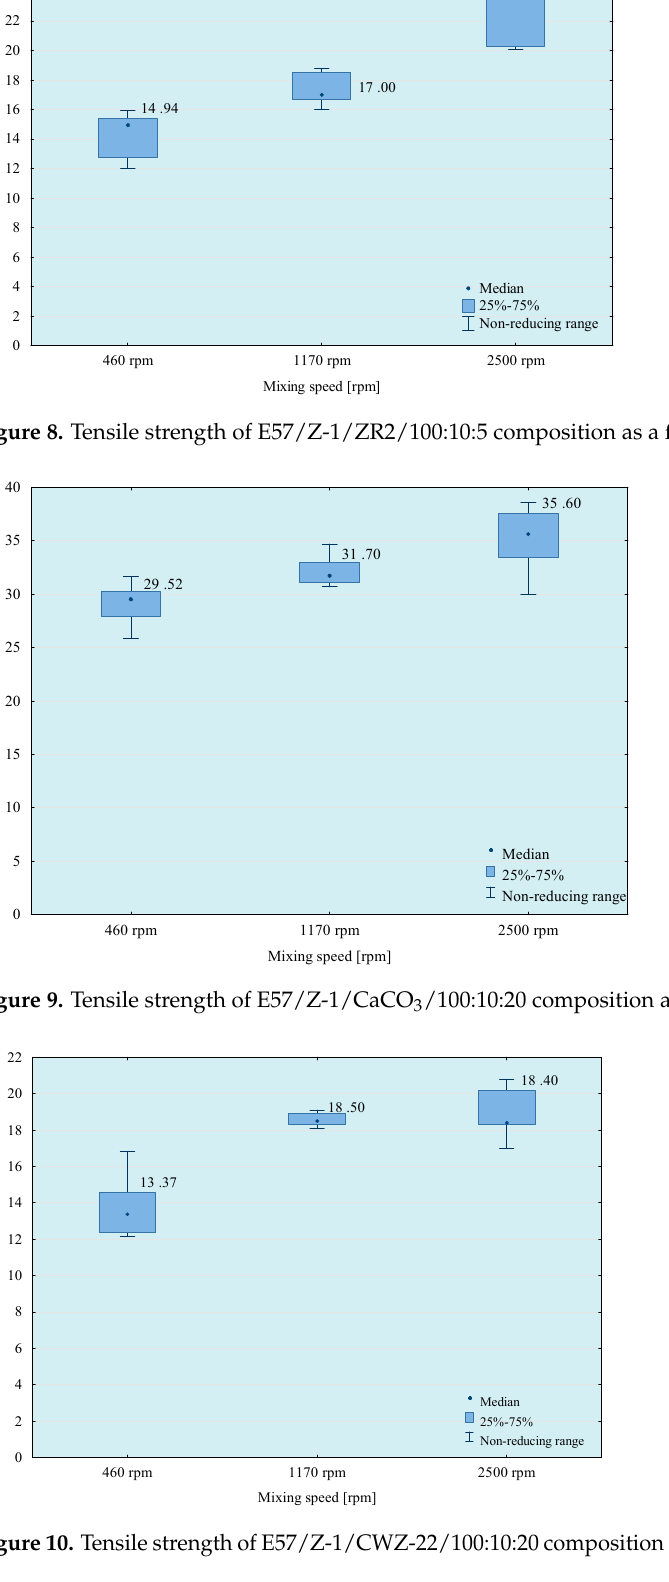
Figure 10. Tensile strength of E57/Z-1/CWZ-22/100:10:20 composition as a function of mixing speed. The normal distribution of the results obtained was then checked. The results of the conducted test are presented in Table